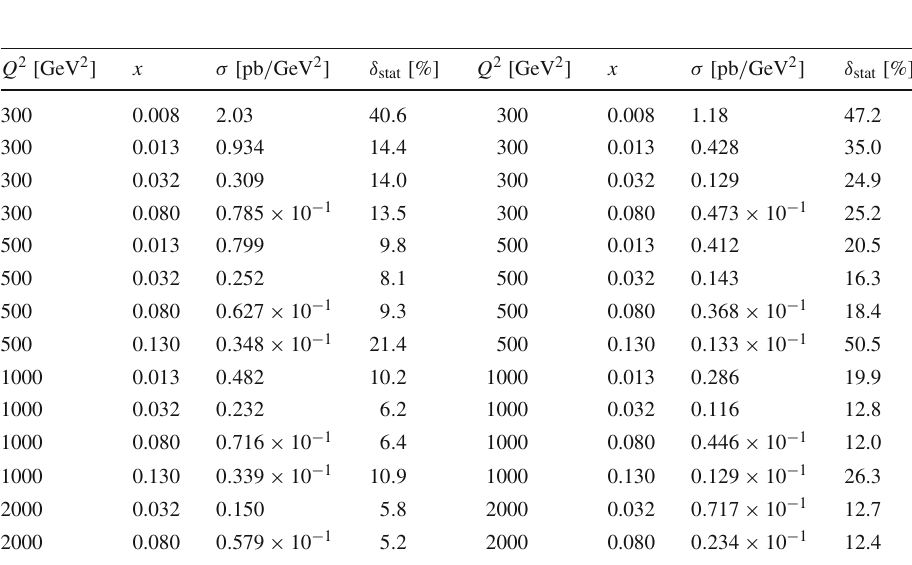
Table 10 The CC e − p cross section σ = d 2 σ CC / dxdQ 2 for lepton polarisation P e = − 25 . 8% (left) and P e = 36 . 0% (right) with their statistical ( δ stat ) uncertainties. The full uncertainties